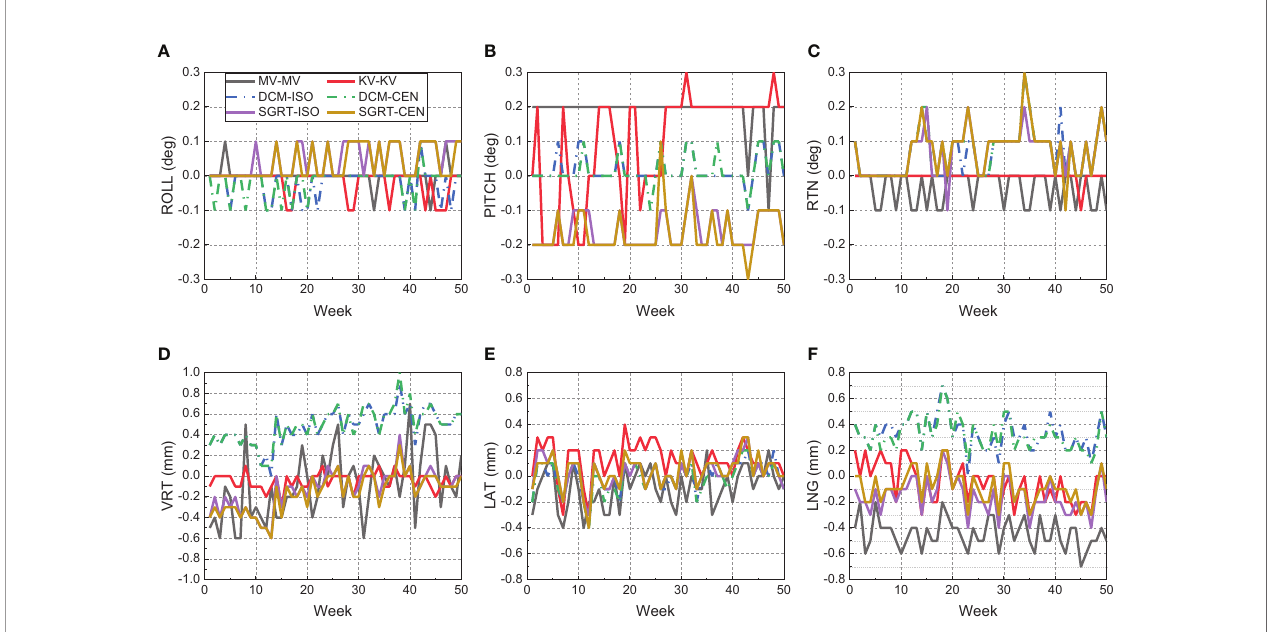
FIGURE 5 | Discrepancies from the CBCT isocenter to kV – kV, MV – MV and AlignRT isocenters over 50 weeks. The trends are listed in 6 directions respectively: (A) ROLL (deg), (B) PITCH (deg), (C) RTN (deg), (D) VRT (mm), (E) LAT (mm) and (F) LNG